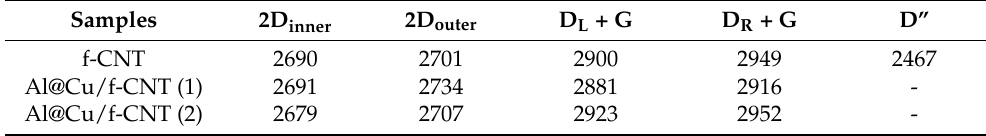
Table 4. The Raman peaks obtained from Lorentzian deconvolutions of the 2D band.